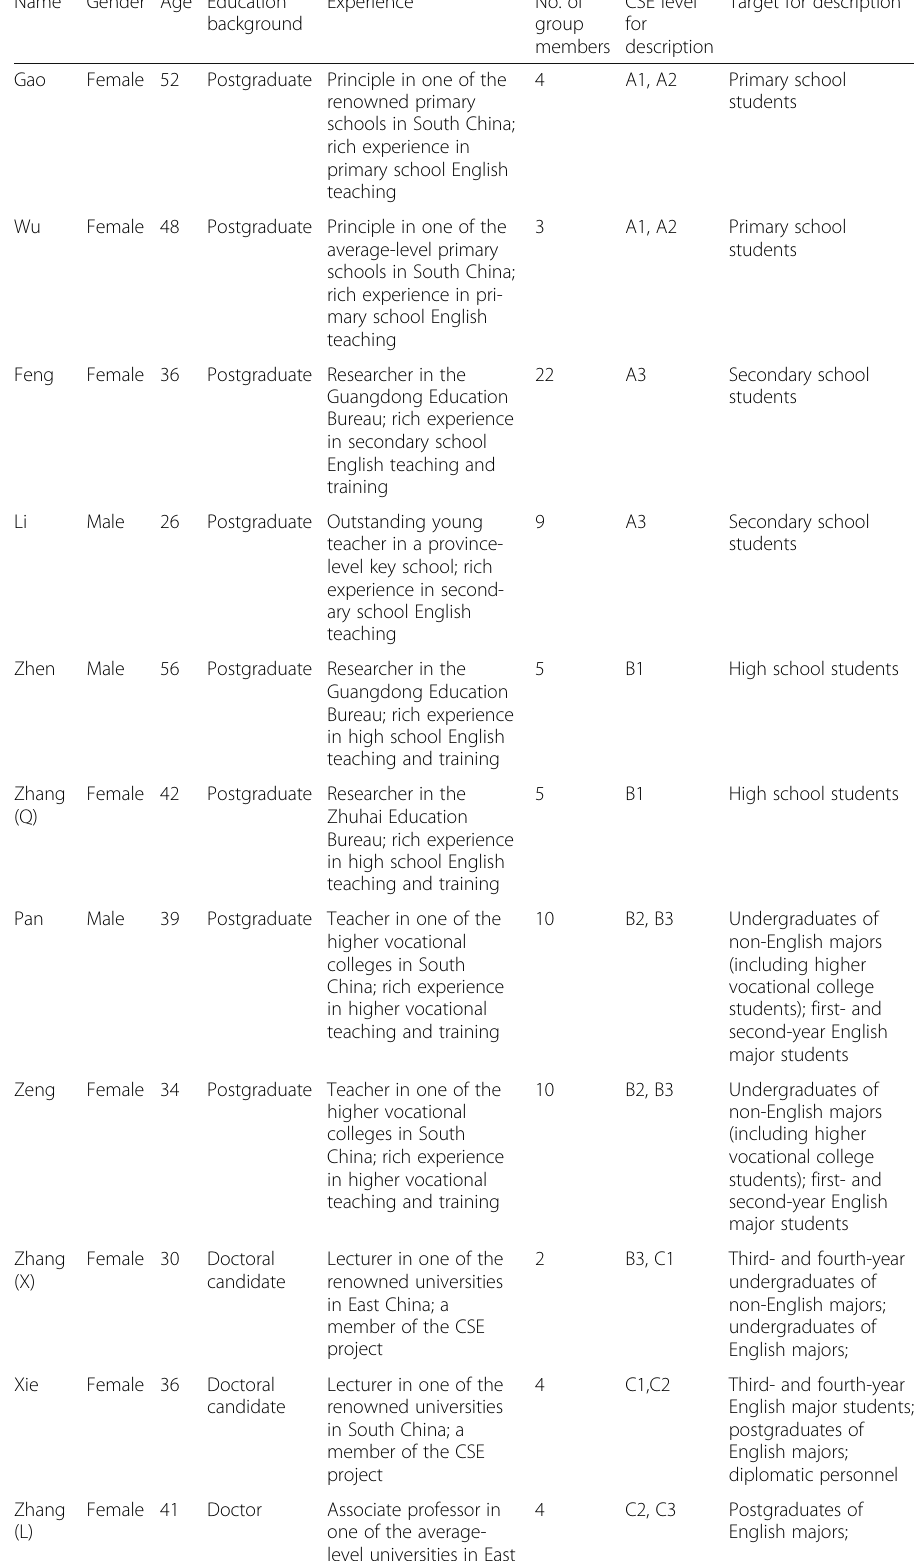
Table 1 Background information of the working group